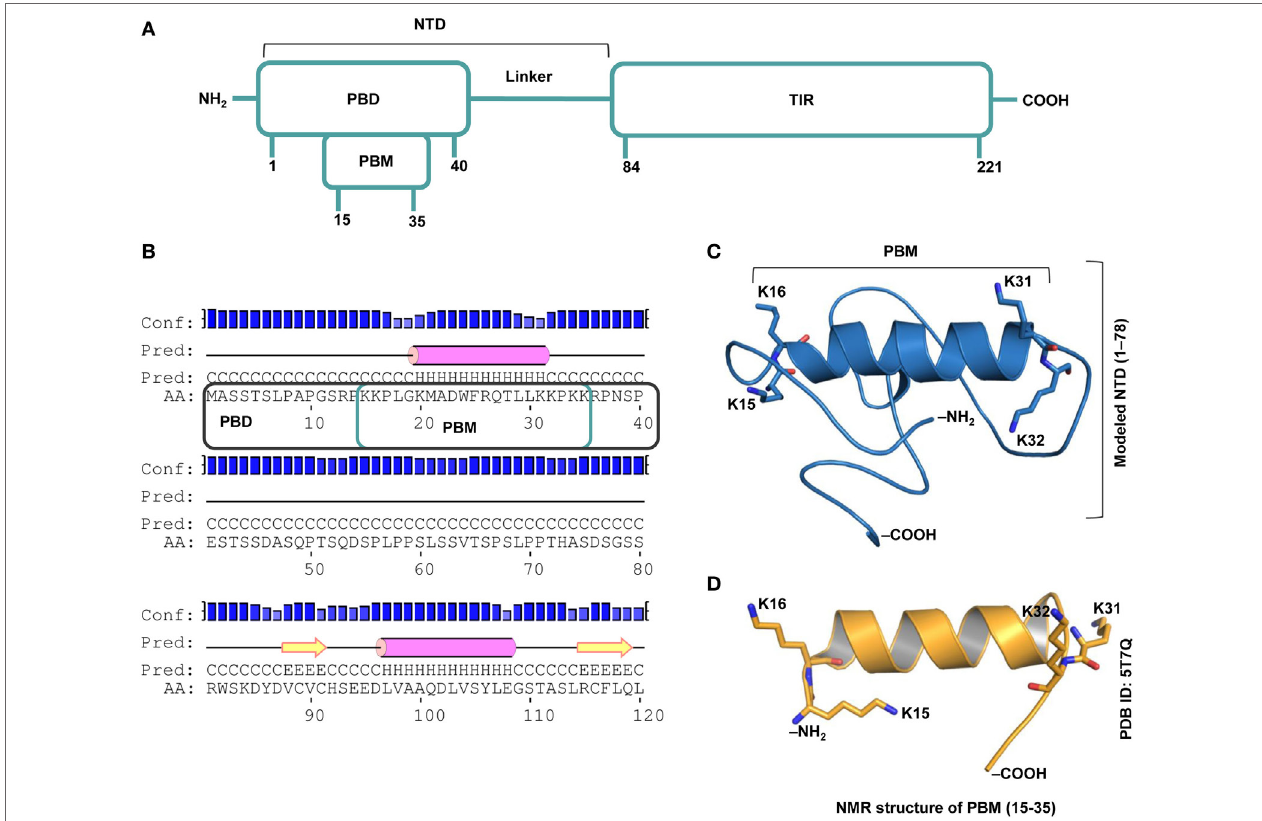
FigUre 1 | Overall topology of the toll/interleukin 1 receptor (TIR) domain-containing adaptor protein (TIRAP). (a) The overall domain organization of TIRAP. Amino acid positions are indicated at the bottom of each segment. (B) The predicted secondary structure of residues 1 − 120 showing the random coiled nature of the N-terminal domain (NTD; residues 1 − 83). The phosphatidylinositol (PI)-binding motif (PBM; residues 15 − 35) and the PI-binding domain (PBD; residues 1 − 40) are enclosed in teal and black boxes, respectively. (c) A three-dimensional model of the NTD (residues 1 − 78) showing the PI-binding residues: K15 and K16 at one end and K31 and K32 at the other end of the α helix (residues 17 − 31). Although NTD spans residues 1–83, we modeled only residues 1–78, as residues 79–221 are present in the crystal structure of the TIR domain (PDB ID: 3UB2). (D) The NMR-derived structure of PBM (PDB ID: 5T7Q; residues 15 −